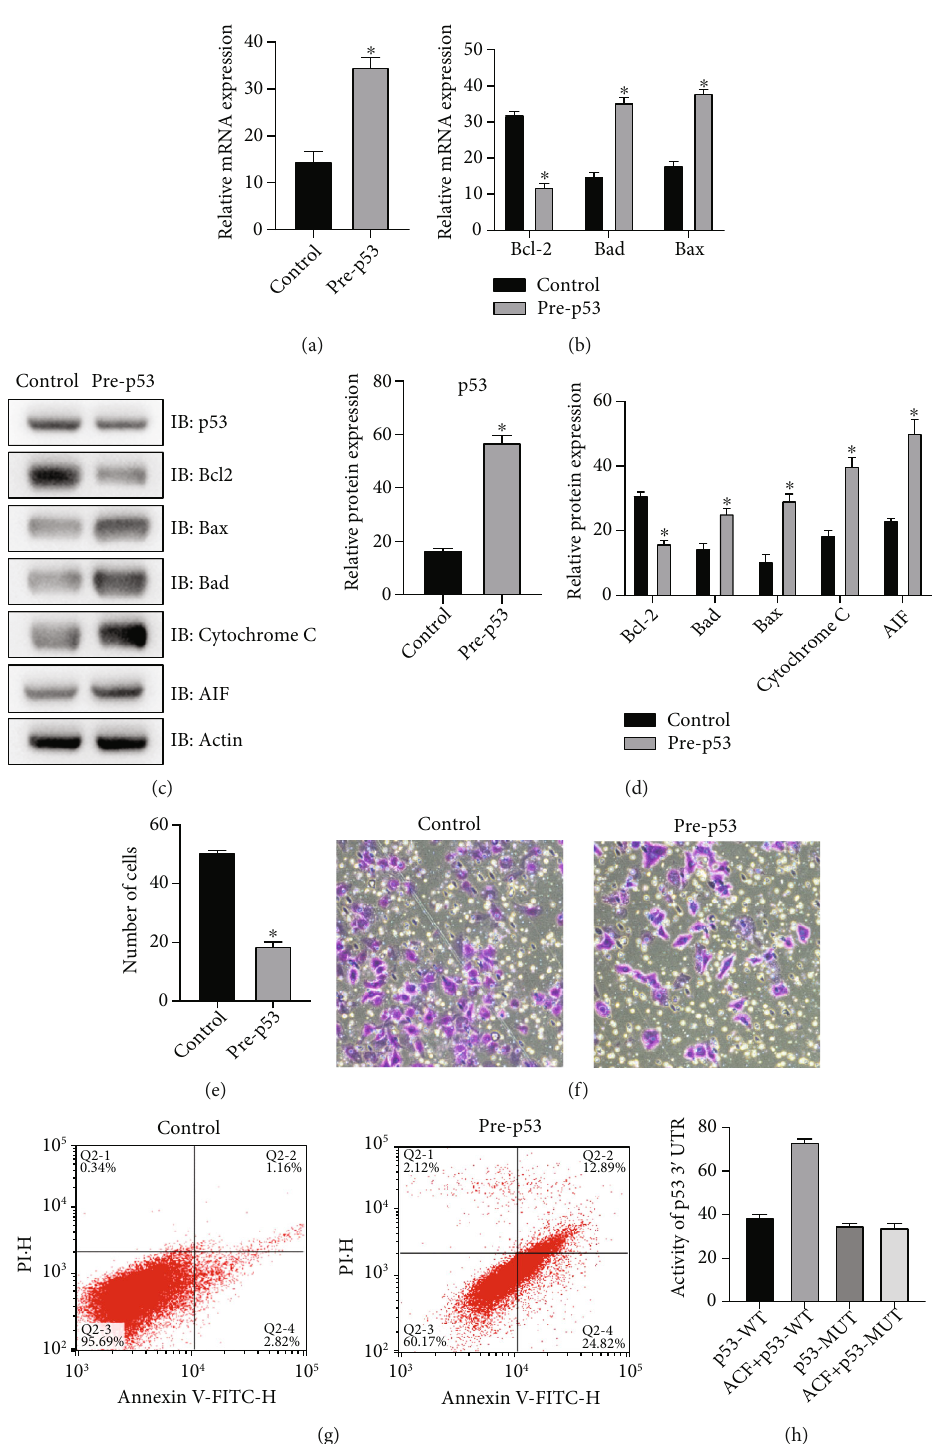
Figure 3: Overexpression of p53, mitochondrial dysfunction, and enhanced radiosensitivity of SW620 cells. (a) Overexpression of p53 was detected successfully by QRT-PCR. (b) The experimental results of QRT-PCR showed that the mRNA expression levels of Bcl-2 decreased with overexpression of p53, while the mRNA expression levels of Bad and Bax increased. (c, d) Western Blot results showed that overexpression of p53 led to a decrease in the expression level of Bcl-2, while the expressions of Bad, Bax, AIF, and cytochrome C increased. (e) MTT results showed that overexpression of p53 weakened the proliferation ability of SW620 cells. (f) The results of in vitro invasion experiment showed that the invasion ability of SW620 cells was inhibited by overexpression of p53. (g) Flow cytometry showed that apoptosis of SW620 cells was enhanced. (h) Luciferase reporting experiment results showed that there was a binding site between p53 and ACF. ∗ P < 0 : 15 , compare with the control